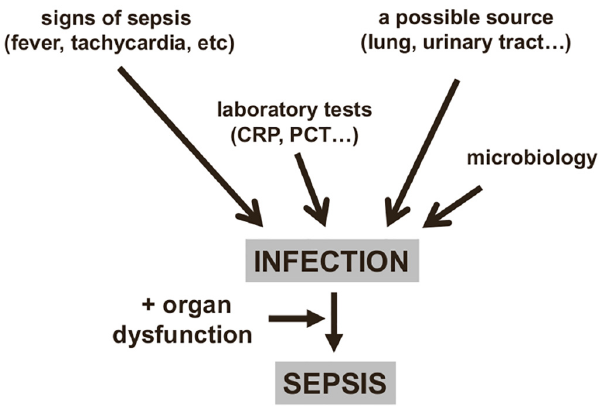
Fig 1. Diagnosing sepsis from infection. An infection can be identified from clinical signs and microbiology findings, providing a diagnosis of sepsis if organ dysfunction is also present. CRP: C-reactive protein; PCT: